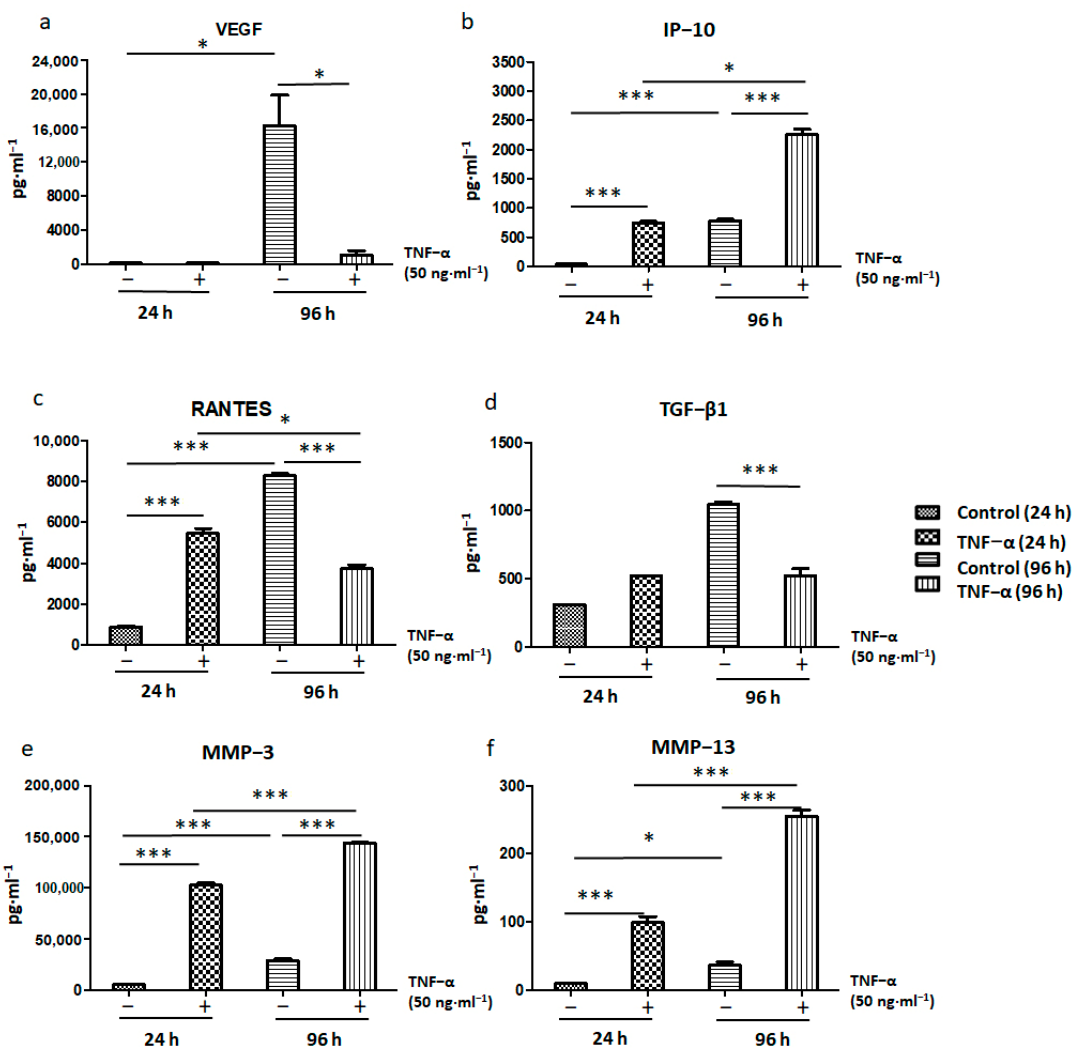
Figure 8. Immune-mediated responses to tumorigenesis inhibition of ( a ) VEGF, ( b ) IP-10, ( c ) RANTES, ( d ) TGF- β 1, ( e ) MMP-3, and ( f ) MMP-13 by TNF- α -treated ADSCs after 24 and 96 h (* p < 0.05, *** p < 0.001).